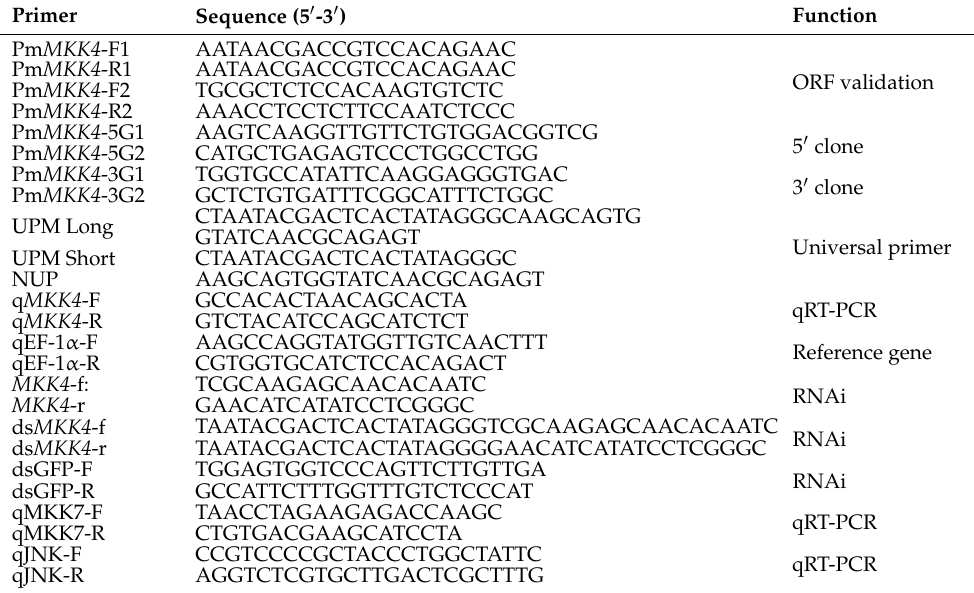
Table 1. Sequences of primers used in this